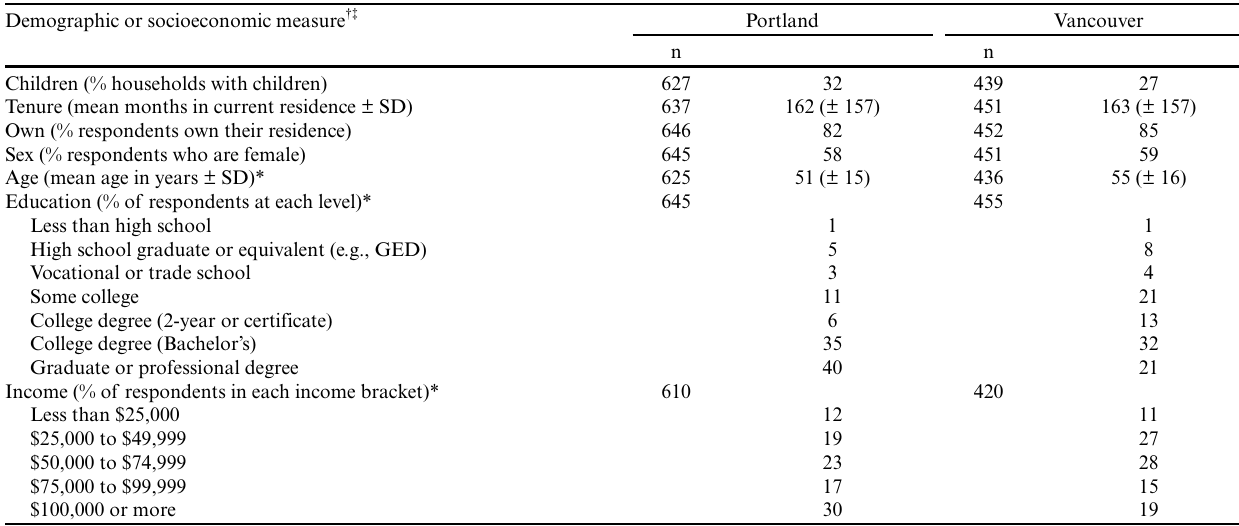
Table 4 . Demographic or socioeconomic variables and sample characteristics of